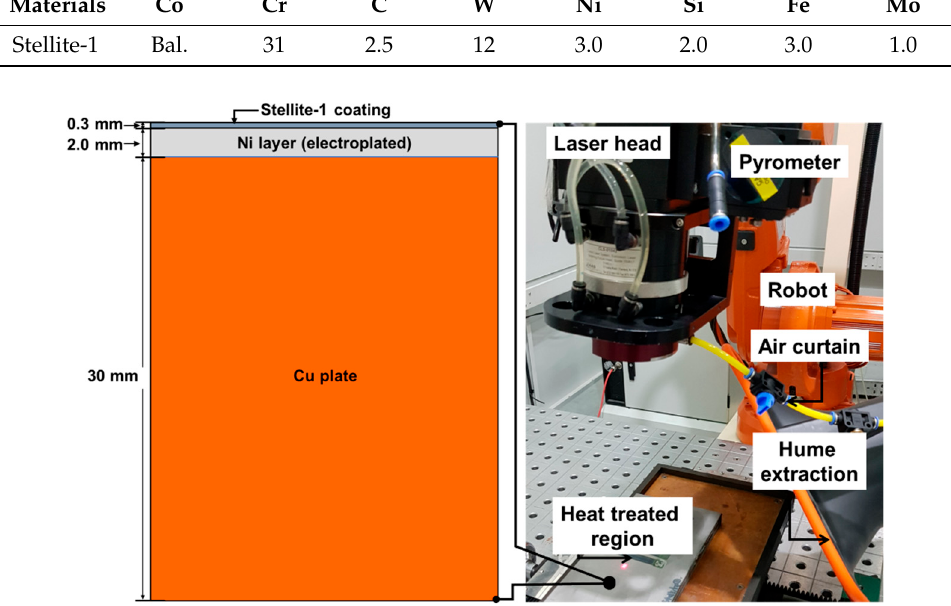
Figure 1. Schematic description of the specimen and the overall view of the experimental setup for laser heat treatment.